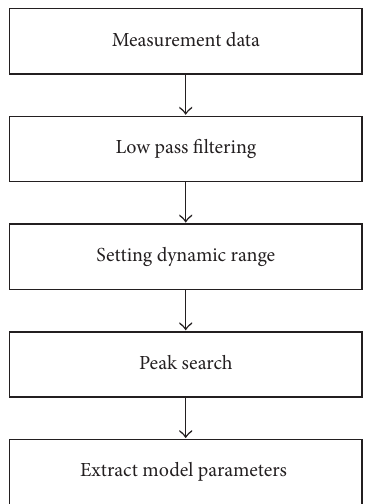
Figure 8: Procedures to extract model